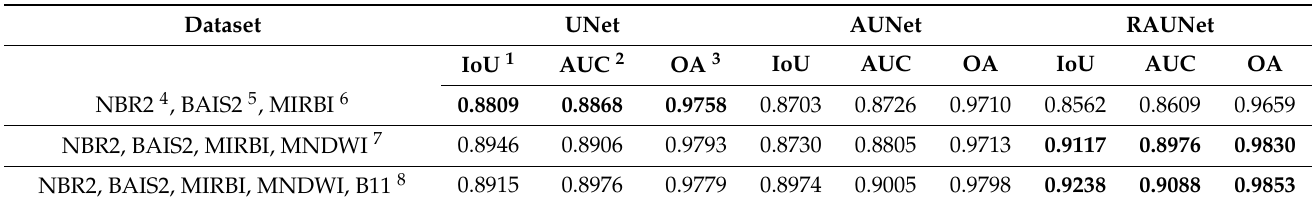
Table 2. The accuracy of the trained UNet, attention UNet (AUNet), and residual attention UNet (RAUNet) using three datasets generated from the top five derivatives of Sentinel-2 data (i.e., NBR2, BAIS2, MIRBI, MNDWI, and B11) to identify the burned areas from the non-burned areas in miombo woodlands.